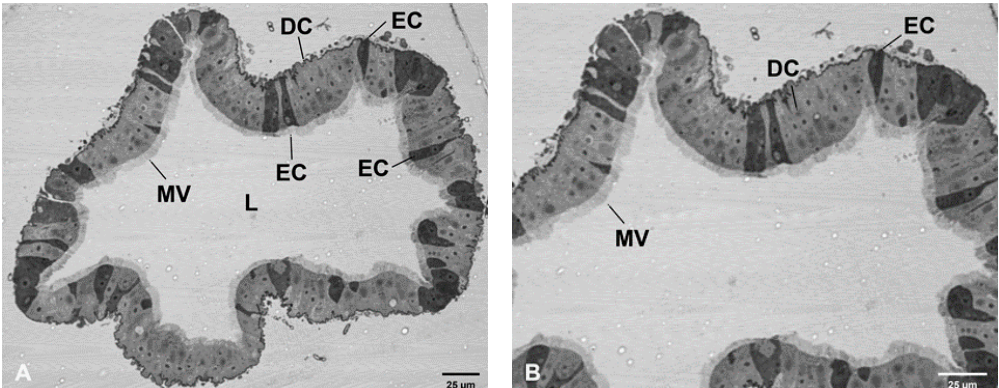
Figure 2. Bright field image of Aedes aegypti MG cross-section. Morphological evidence of enteroendocrine cells (EC) integral to the MG monolayer surrounding the lumen (L) in the mosquito PMG. ECs have a darker appearance, have a conical, flask-like shape, unlike neighboring lighter appearing digestive cells (DC). MV, microvilli. ( A ) 100× ( B ) 200×.